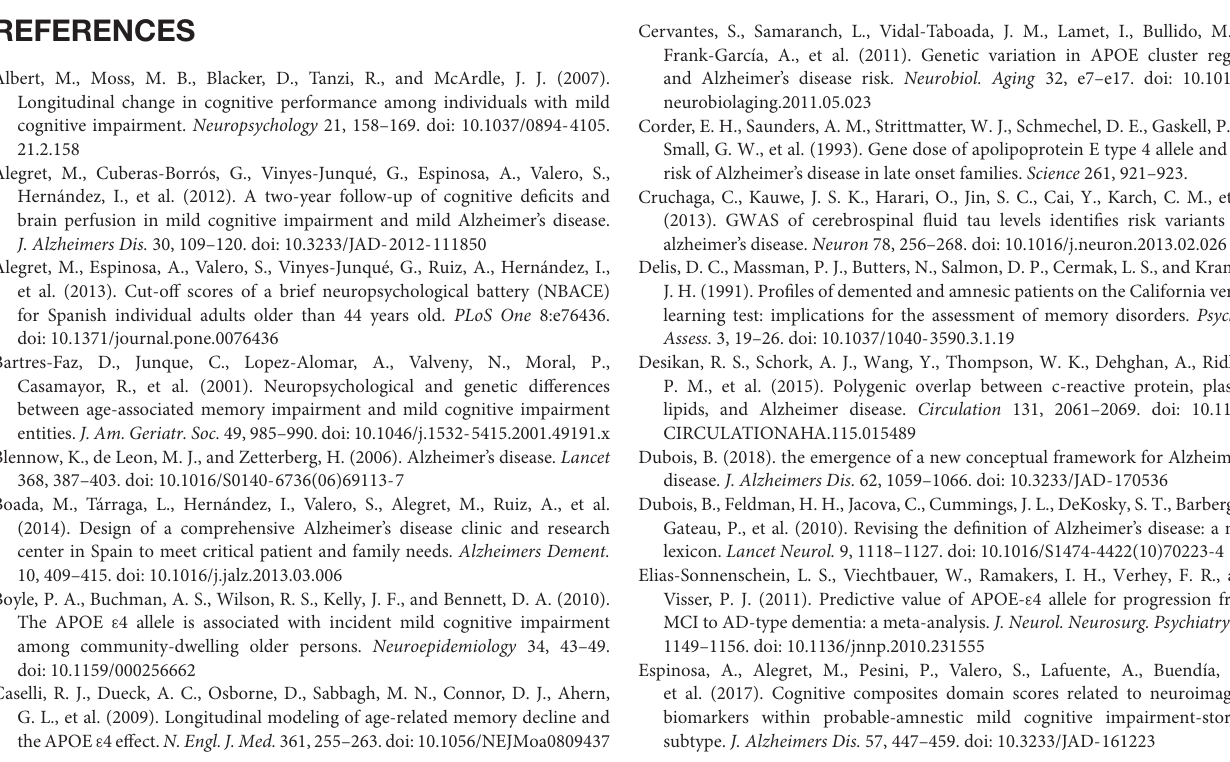
TABLE S7 | GROUP: MCI total sample. TABLE S8 | GROUP: amnestic MCI. TABLE S9 | GROUP: non-amnestic MCI. TABLE S10 | Supplementary information from the Pr-aMCI-storage subtype on ACE